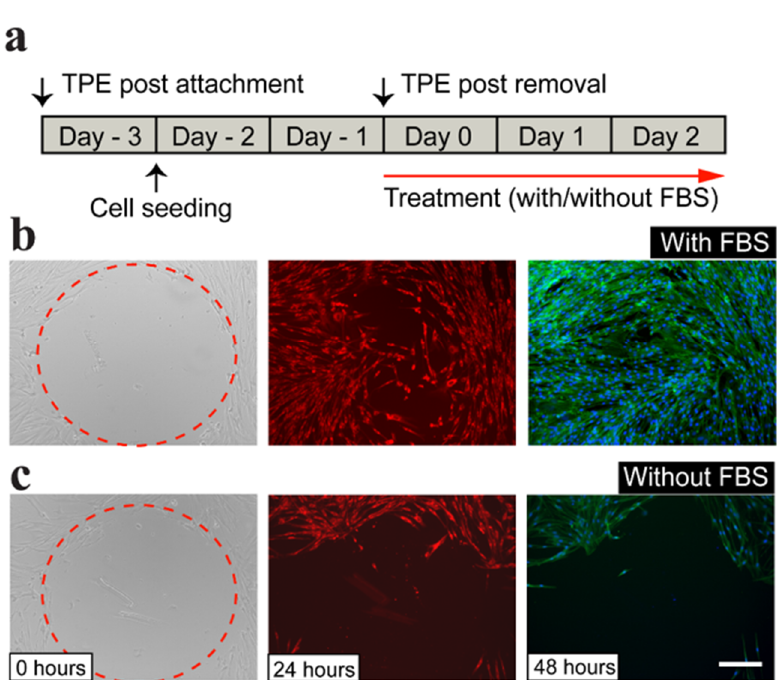
Figure 4. ( a ) Schematic of the experimental design and timeline of cell treatment. After TPE post removal, cells are cultured for two days in culture media with 10% FBS ( b ) and without FBS ( c ). For migration assay, we stain cell using CellTracker (red, 24 h) and phalloidin (green, 48 h). The captured images are post-processed for quantitative analysis. Dashed lines indicates boundary of the original cell patterned area. The scale bar shows 200 µm.